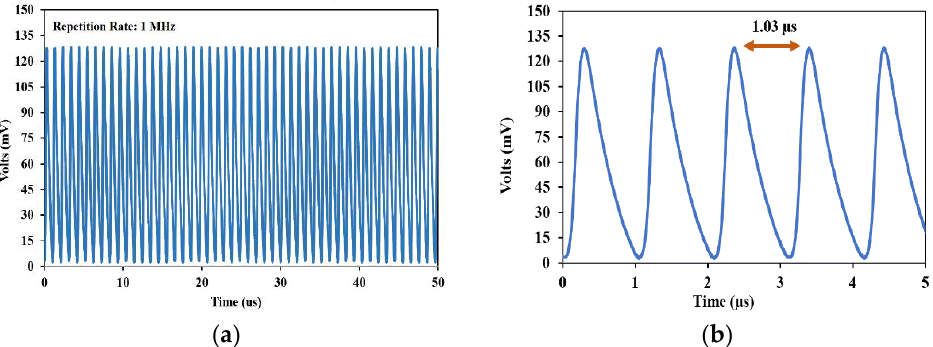
Figure 7. Oscilloscope pulse train at a pump power of 175.87 mW: ( a ) time-span of 50 µs ( b ) close-up pulse train at 5 µs time-span with 1.03 µs for each interval.